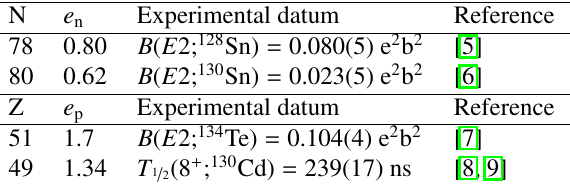
Table 1. E ff ective charges used in N u S hell X calculations. B ( E 2) strengths are for the 0 +